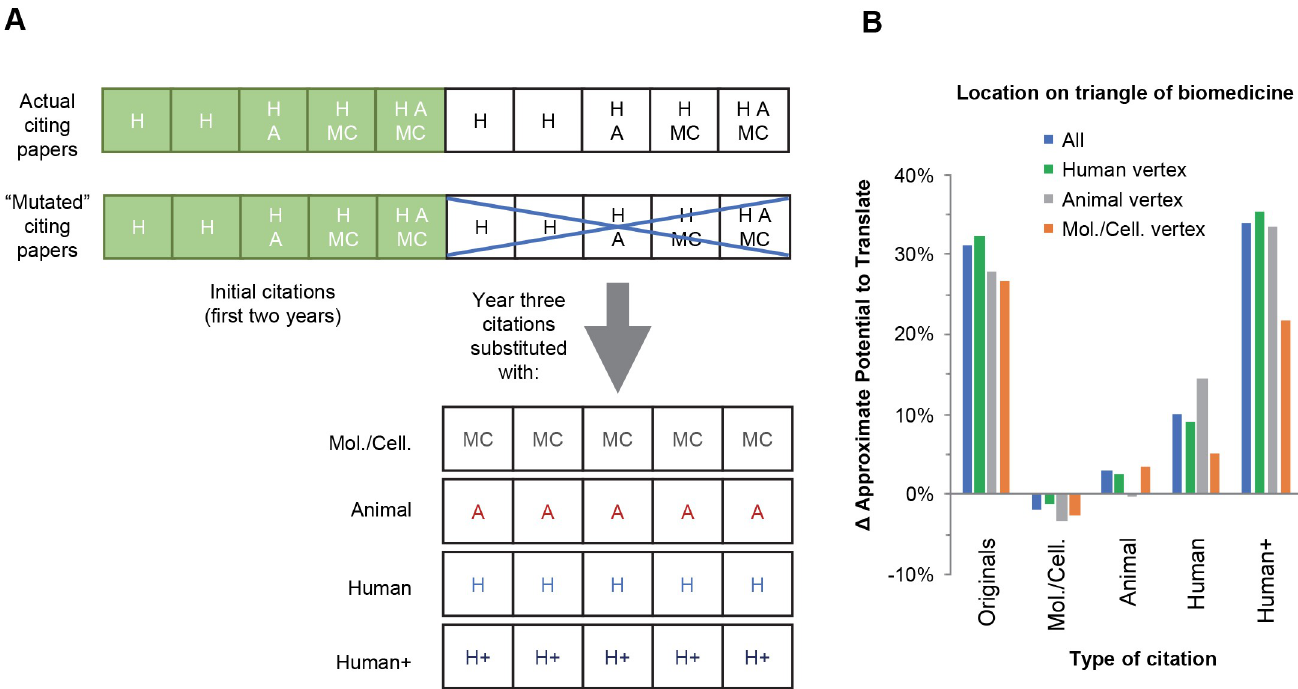
Fig 4. Effect on the translational potential of a paper after it receives different classes of citations. Testing the change in APT scores after directly manipulating the citing networks of 14,789 articles by adding or changing the types of citations. (A) Sample of a paper in this analysis that has 5 citations in the second year after publication (green squares) and an additional 5 citations in year 3 (white squares). We replaced the citations from year 3 with 5 citations that were MC, A, H, or H+. The same procedure was repeated for articles that populate vertices of the triangle of biomedicine (i.e., articles that were at least 95% H, A, or MC). (B) Effect on APT scores after manipulating the citing networks of all articles and for subsets articles that populate the H, A, and MC vertices. “Originals” indicates the change in APT score associated with the naturally occurring citations after year 3. A, Animal; APT, Approximate Potential to Translate; H, Human; H+, Human with Disease, Therapeutic/Diagnostic Approaches, and Chemical/Drug terms; MC, Molecular/Cellular; Mol./Cell., Molecular/Cellular.